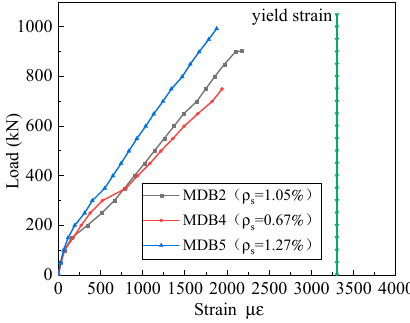
Figure 14. Relation curve between the ρ s and longitudinal reinforcement strain.